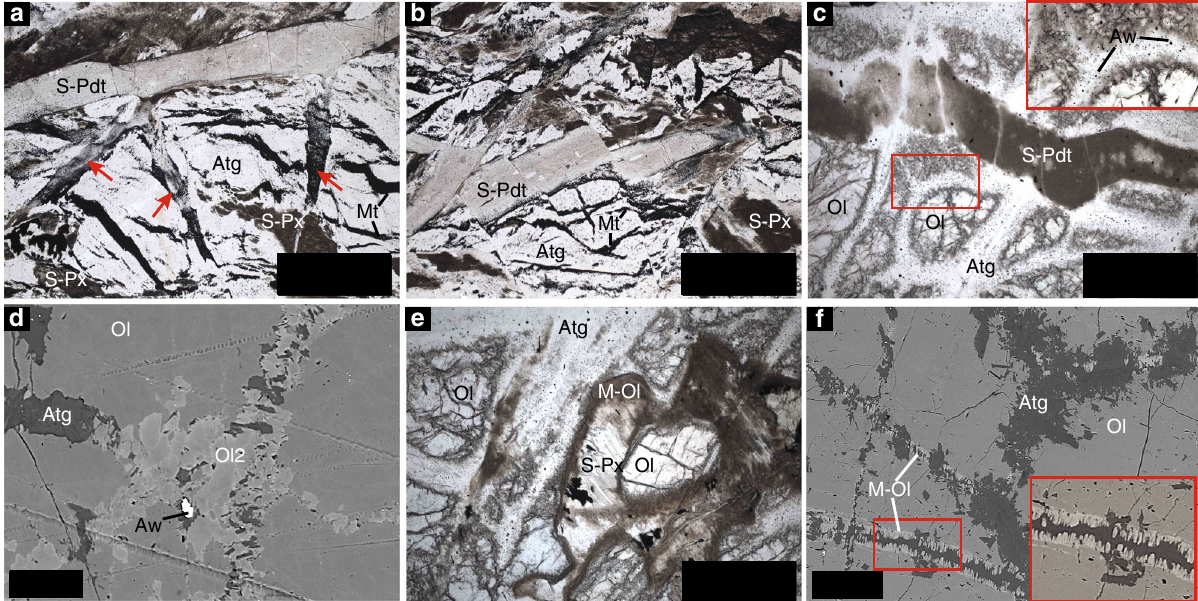
Fig. 1 Microstructural features of antigorite serpentinization. a – c Examples of statically serpentinized pseudotachylyte (S-Pdt)-bearing peridotite from the blueschist-facies Cima di Gratera unit ( a ) and the eclogite-facies San Petrone unit ( b , c ). Note the absence of post-pseudotachylyte ductile deformation. d Backscattered-electron image showing the stage of incipient serpentinization proceeding along pre-existing deformation bands characterized by olivine subgains (Ol2) (see Supplementary Fig. 2 for details). Note the presence of awaruite (Aw) in association with antigorite. e Photomicrograph showing the early transformation of orthopyroxene relative to mantle olivine (see Supplementary Fig. 7 for mineralogical details). f Backscattered-electron image showing the formation of metamorphic olivine (M-Ol) together with antigorite during high-pressure serpentinization. Note the difference between the secondary olivine formed along a pre-serpentinization cataclastic band ( d ) and the metamorphic olivine related to the serpentinization event. Scale bars: a , b 600 µ m; c , e 350 µ m; d 20 µ m; f 40 µ m. Other mineral abbreviations: Atg antigorite, Mt magnetite, S-Px serpentinized mantle pyroxene, Ol mantle